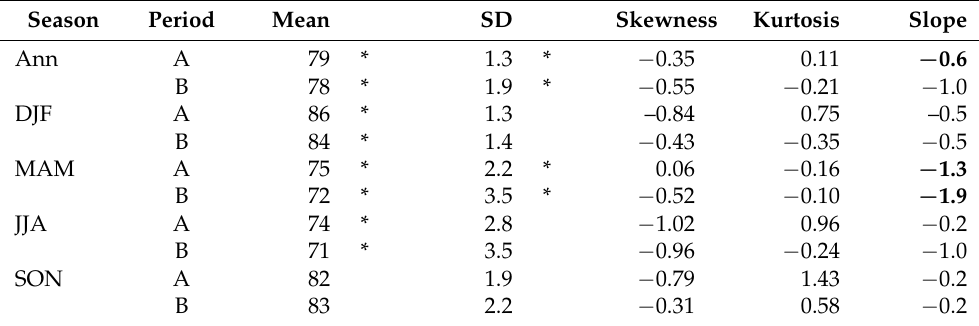
Table 6. Selected statistical characteristics of annual (Ann) and seasonal (DJF, MAM, JJA, and SON) mean relative humidity series in the Czech Republic in the 1961–1990 (A) and 1991–2020 (B) periods: means and standard deviations (SD) are in %, linear trends in %/10 years (in bold statistically significant at the 0.05 significance level). The asterisk * indicates statistically significant differences of a given characteristic between two 30-year periods.